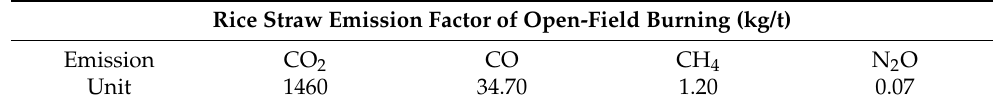
Table 8. Emission released from rice straw open field burning